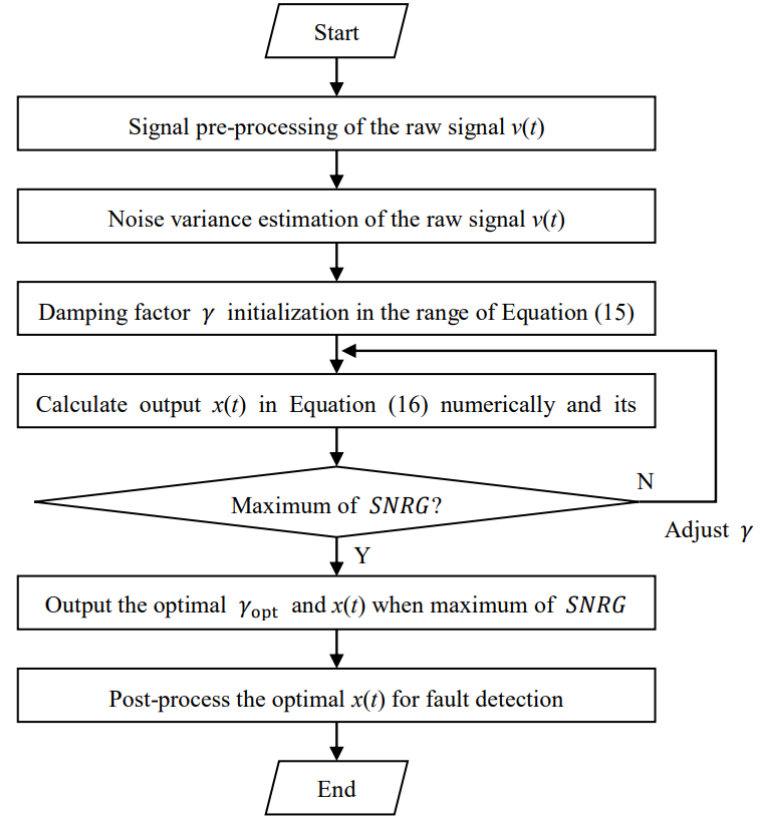
Figure 1. The flowchart of the proposed method.